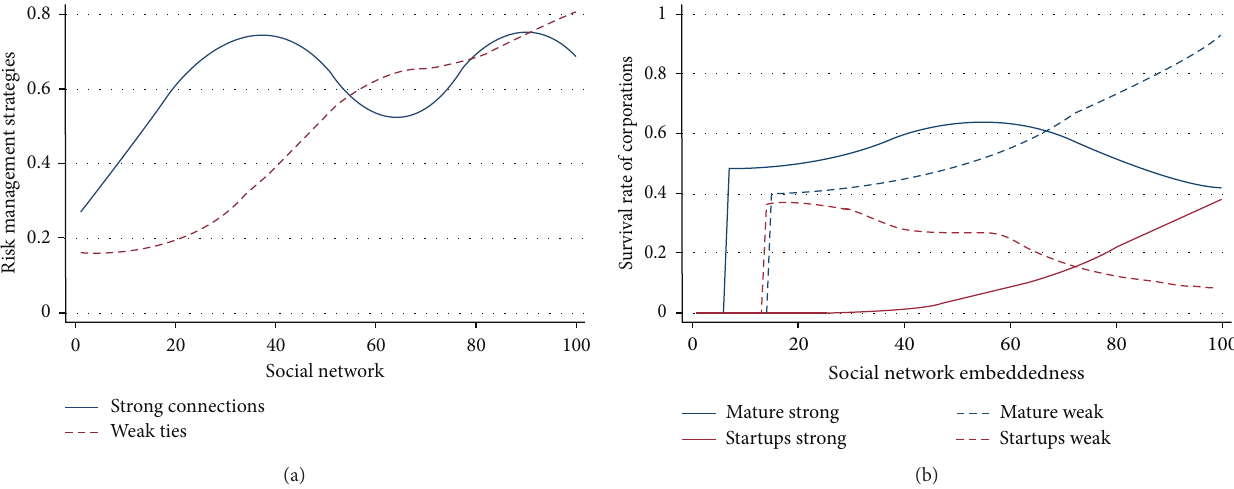
Figure 6: Simulation analysis of the extended model. (a) Social networks and risk management strategies. (b) Social networks and corporate scale.